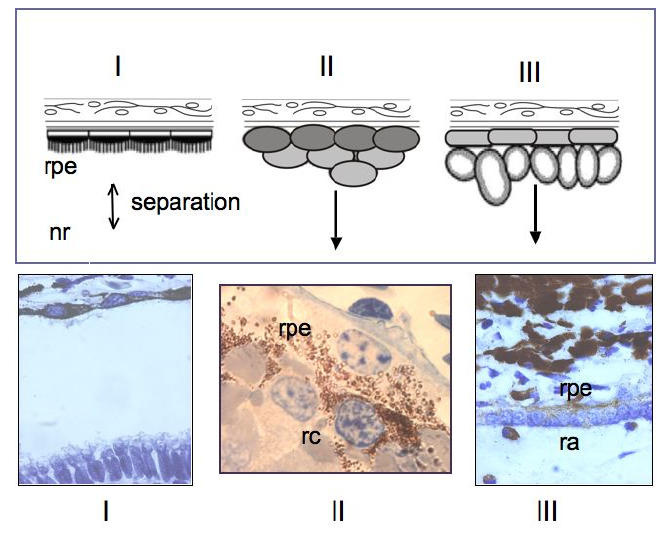
Figure 7. Early stages of newt retinal pigment epithelium (rpe) reprogramming in vivo. I—neural retina is separated from the RPE; II—some RPE cells come out of the layer and form retinal anlage (III). Others divide and return to their original differentiation. rc—reprogramming cells, ra—retinal anlage.